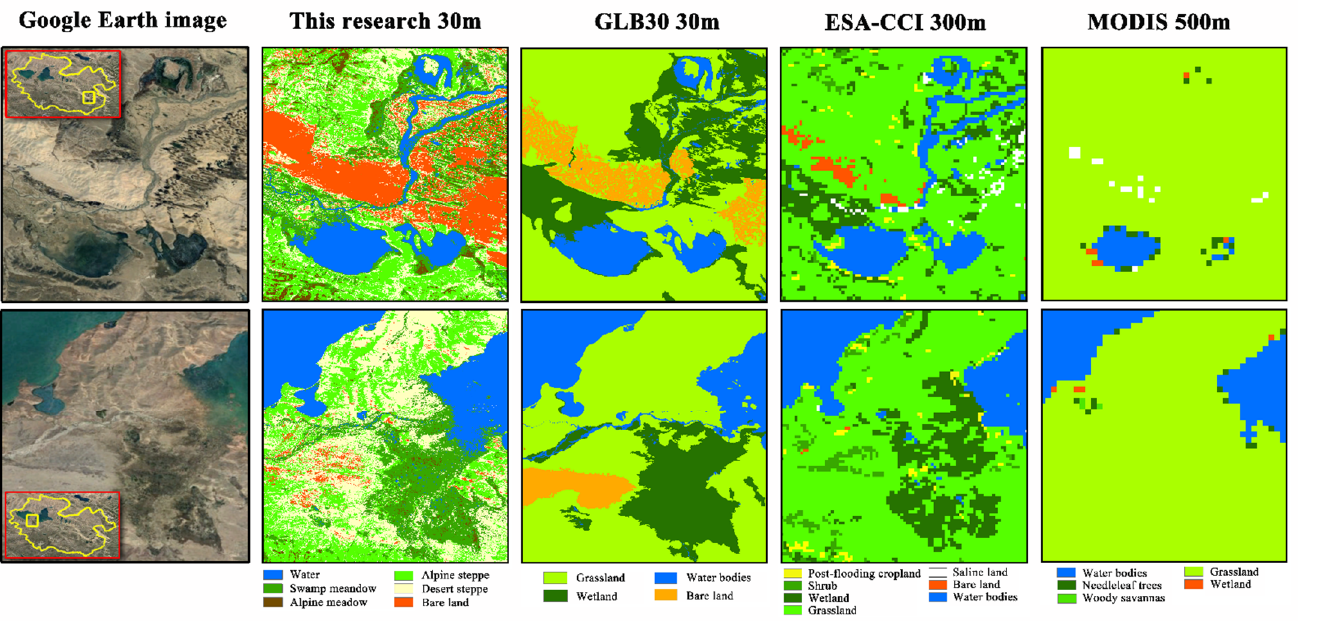
Figure 7. Comparison of 2 samples in the headwater of Huang River between other products and the results of this paper.